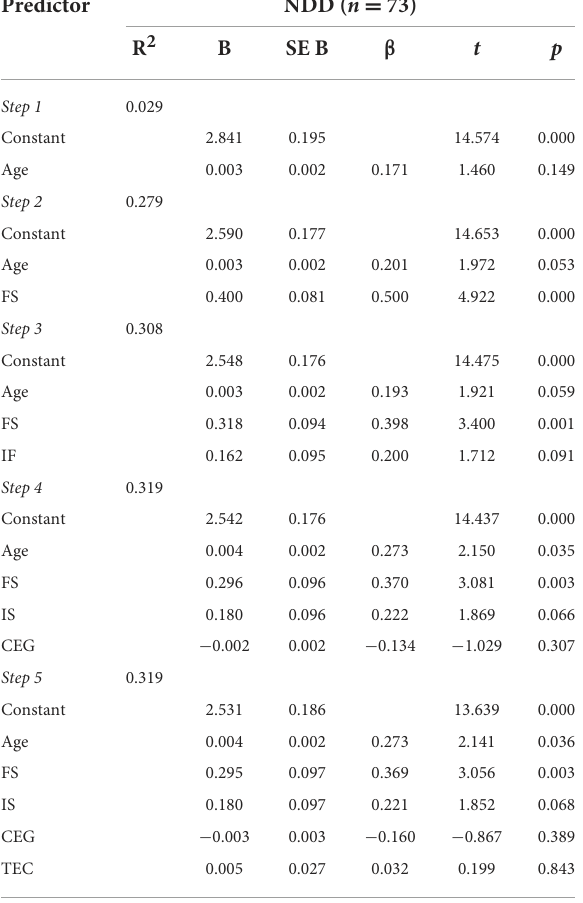
TABLE 3 Summary of the regression coefficients of Resilience Scale total scores within the NDD